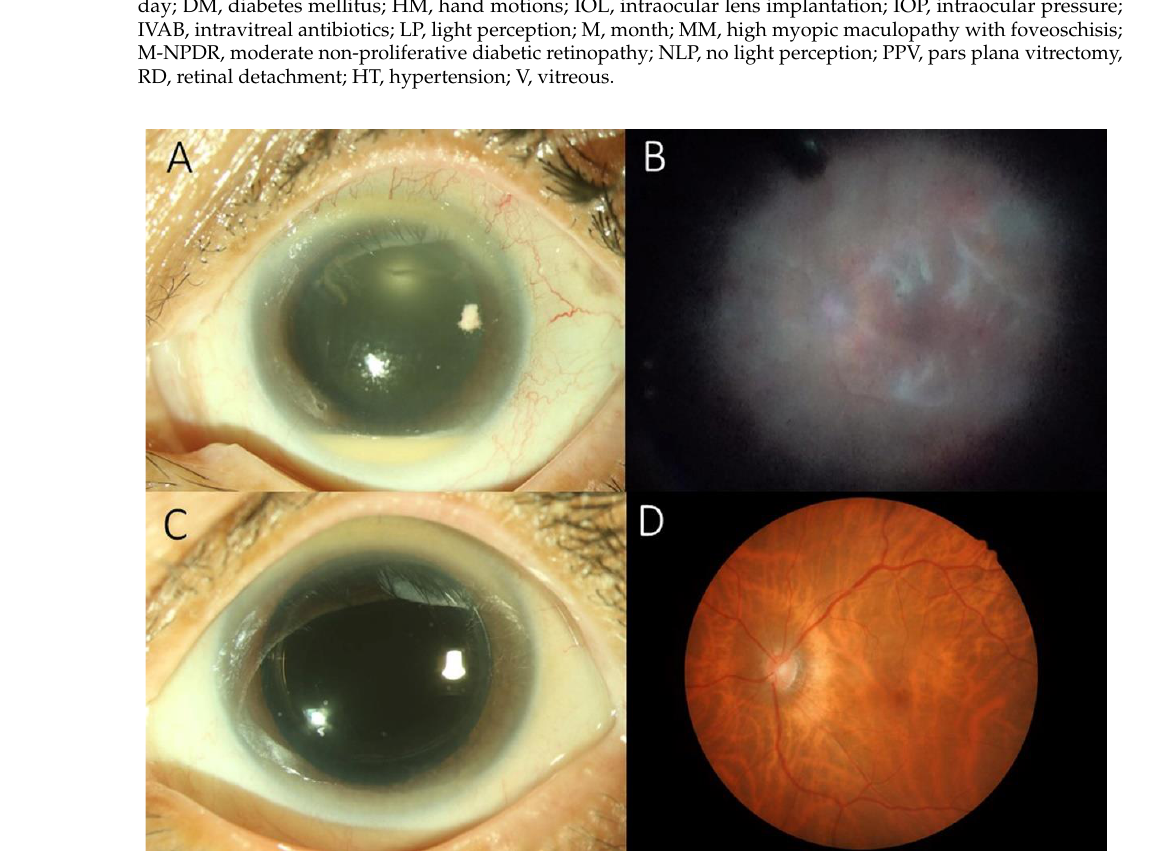
Table 1. Clinical summary of patients with postoperative endophthalmitis caused by S. lugdunensis .